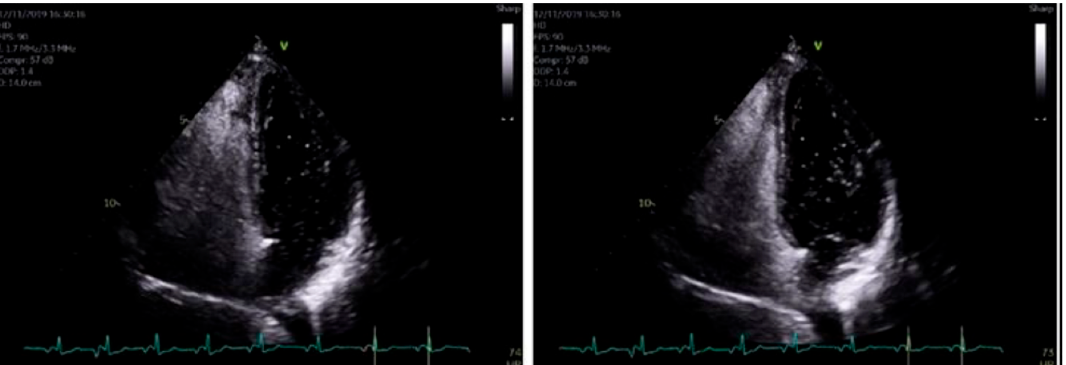
Figure 5. When using bubble transthoracic echocardiogram, bubbles will be visualized entering the right heart using the apical four-chamber or subcostal views. Once there is complete opacification of the right atrium (RA), cardiac cycles are counted [5]. In patient without any type of shunt present, no bubbles should appear in the left heart. If, bubbles appear in the left atrium (LA) after three cardiac cycles, an intracardiac shunt is likely